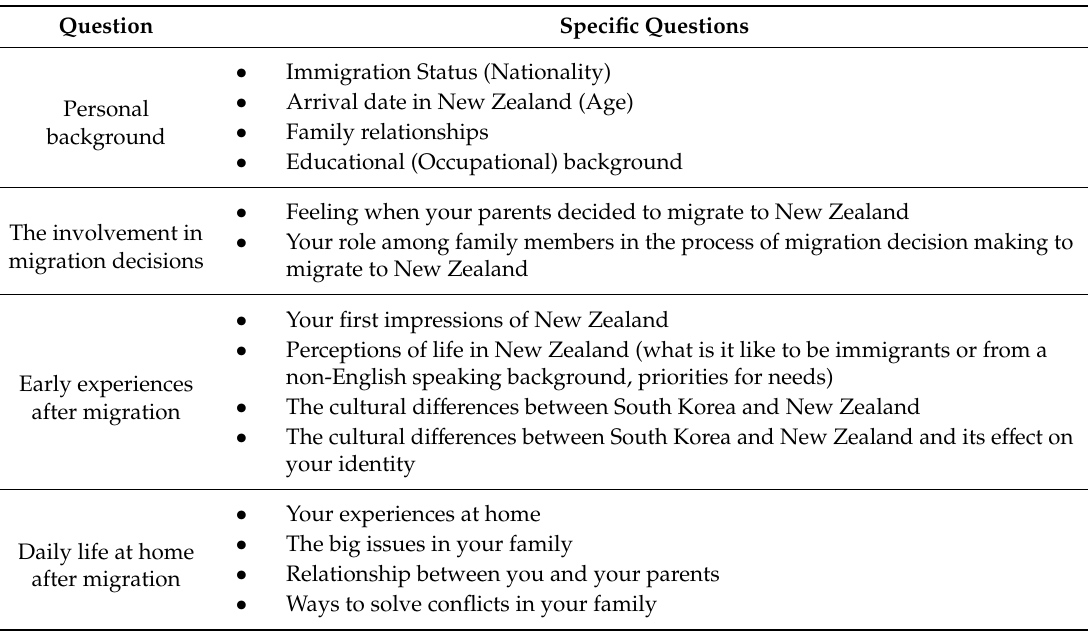
Table 2. Interview guide for exploring the role of family and school as spaces for 1.5 generation South Korean-New Zealanders’ adjustment and identity